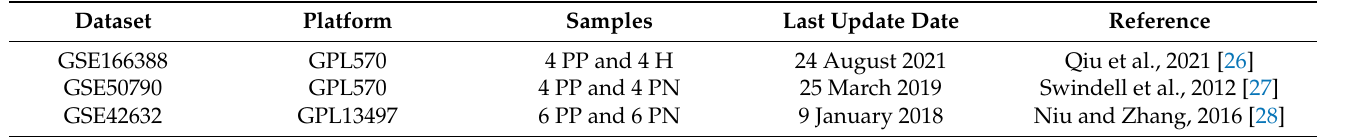
Table 4. Information for psoriatic GEO